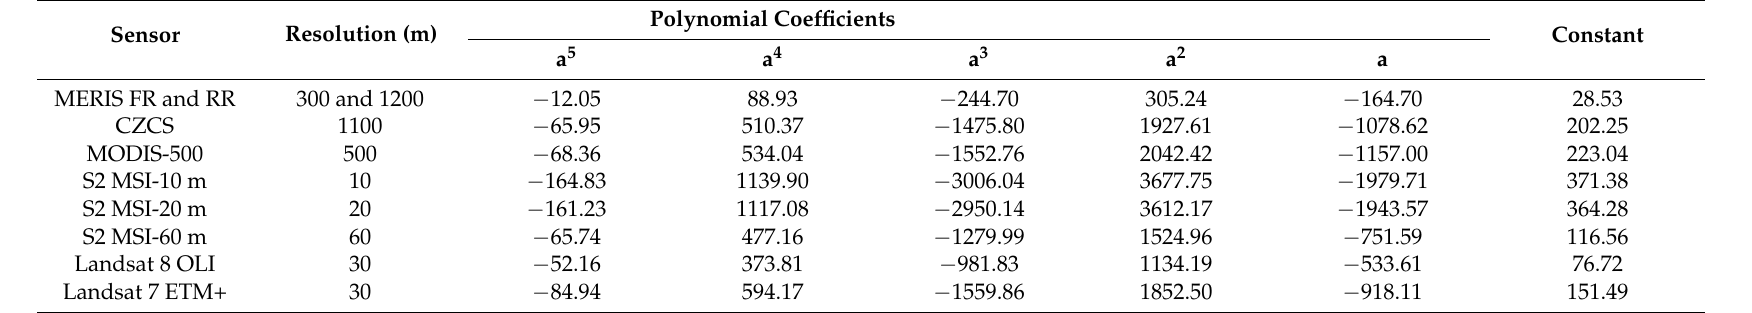
Table 2. Polynomial coefficients to calculate the hue-angle offset ( ∆ ) for each